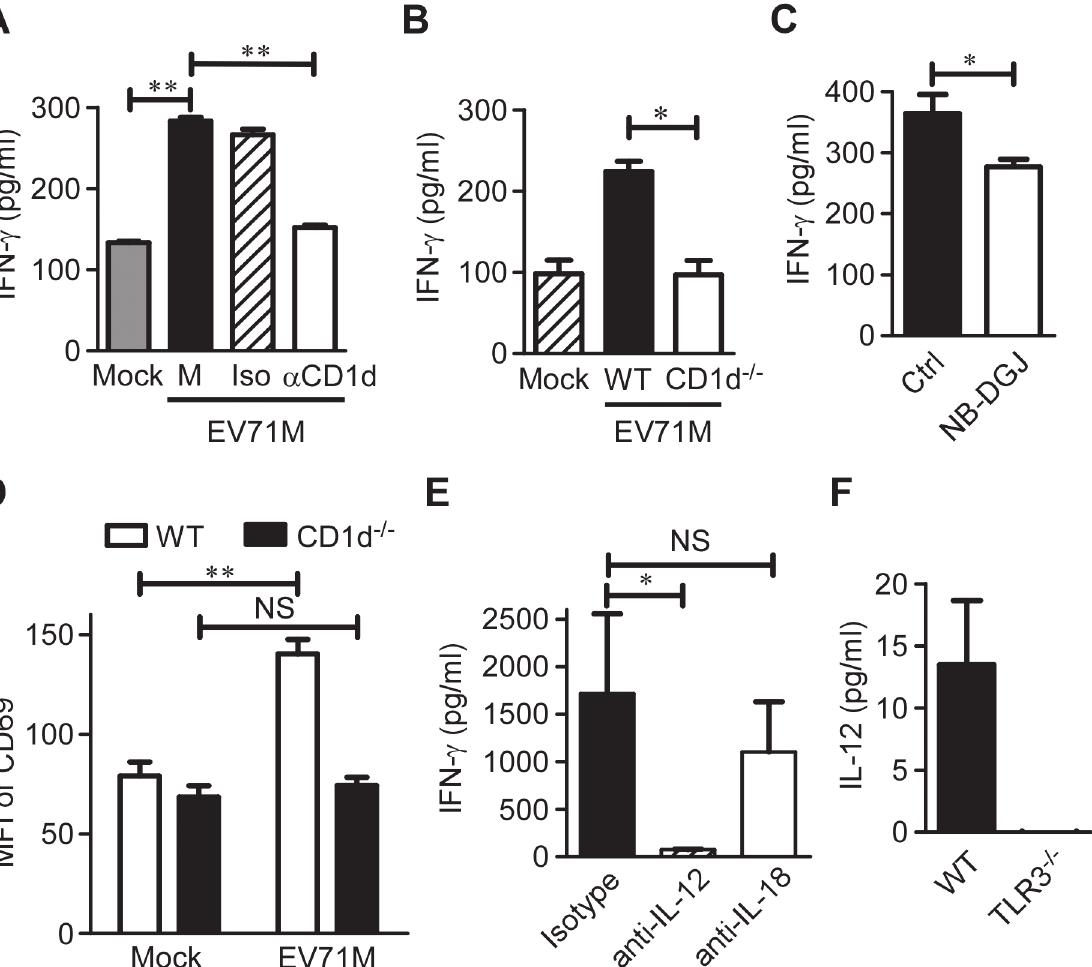
Figure 4. IL-12 and endogenous CD1d antigens are both required for full iNKT cell activation in EV71 infection. (A) EV71M-infected or-uninfected WT macrophages (Mock) were co-cultured with purified iNKT cells in the presence of neutralizing anti-CD1d ( α CD1d), isotype control antibodies (Iso) or medium alone (M). (B) EV71M-infected or – uninfected WT or CD1d-deficient (CD1d -/- ) macrophages were co-cultured with purified iNKT cells. (C) EV71-infected WT macrophages were co-cultured with purified iNKT cells in the presence of the lipid synthesis inhibitor NB-DGJ or medium alone. (D) Seven-day-old WT or CD1d -/- neonates (n = 3 – 5) were adoptively transferred with 5×10 5 purified iNKT cells or saline control intraperitoneally and infected with 2×10 5 PFU of EV71M. After 16 hours, splenocytes of saline (mock)-treated or EV71M-infected WT or CD1d -/- mice were stained with TCR β , CD1d tetramer, CD69 and DAPI. The CD69 MFI levels on iNKT cells are shown. (E) EV71M-infected WT macrophages were co-cultured with purified iNKT cells in the presence of neutralizing anti-IL-12, anti-IL-18 or isotype control antibodies. The IFN- γ concentrations in the 24-hour culture supernatants were quantified by ELISA. (F) The IL-12 (p70) concentrations in the supernatants of WT or TLR3 -/- macrophages infected with 10 MOIs of EV71M. All results represent the mean ± SD. NS, not significant; * , P < 0.05; ** , P < 0.01. Data are representative of three (A, B, C, E, F) or two (D) independent